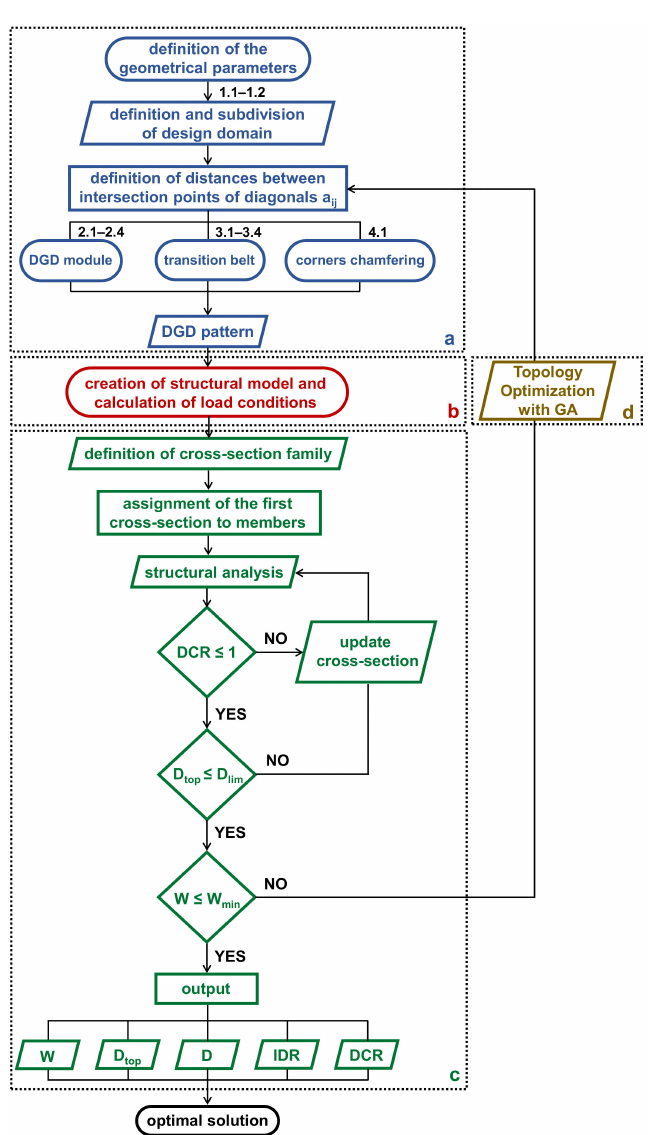
Figure 1. Flow chart of the structural grammar; DGD = DiaGriD, DCR = Demand to Capacity Ratio, D top = Displacement at the top of the building; D lim = limit Displacement at the top of the building, W = Weight, W min = minimum Weight obtained after optimization, D =Displacement, IDR = Interstorey-Drift, GA =Genetic